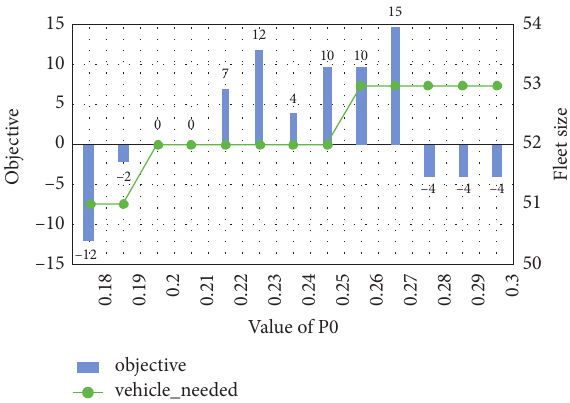
Figure 10: The objective and the fleet size change with P